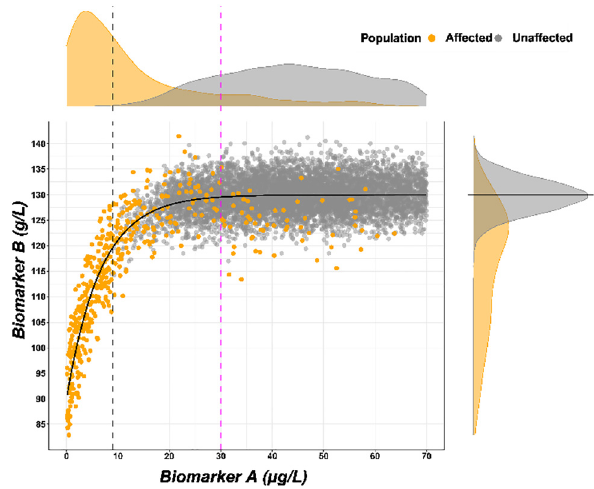
Figure 2: Example of a correlation graph showing the association between two related biomarkers, alongside their smoothed histograms showing the distribution of results. The example is based on a simulated functional relationship between biomarker A and B. Biomarker A is based on a log-normal distribution, while Biomarker B is a non-linear transformation of biomarker A, with added noise. Two variations of biomarker A are simulated,one with 5%of the sample(n=10,000) havingsubclinical disease (orange), and the other unaffected/normal (gray). As